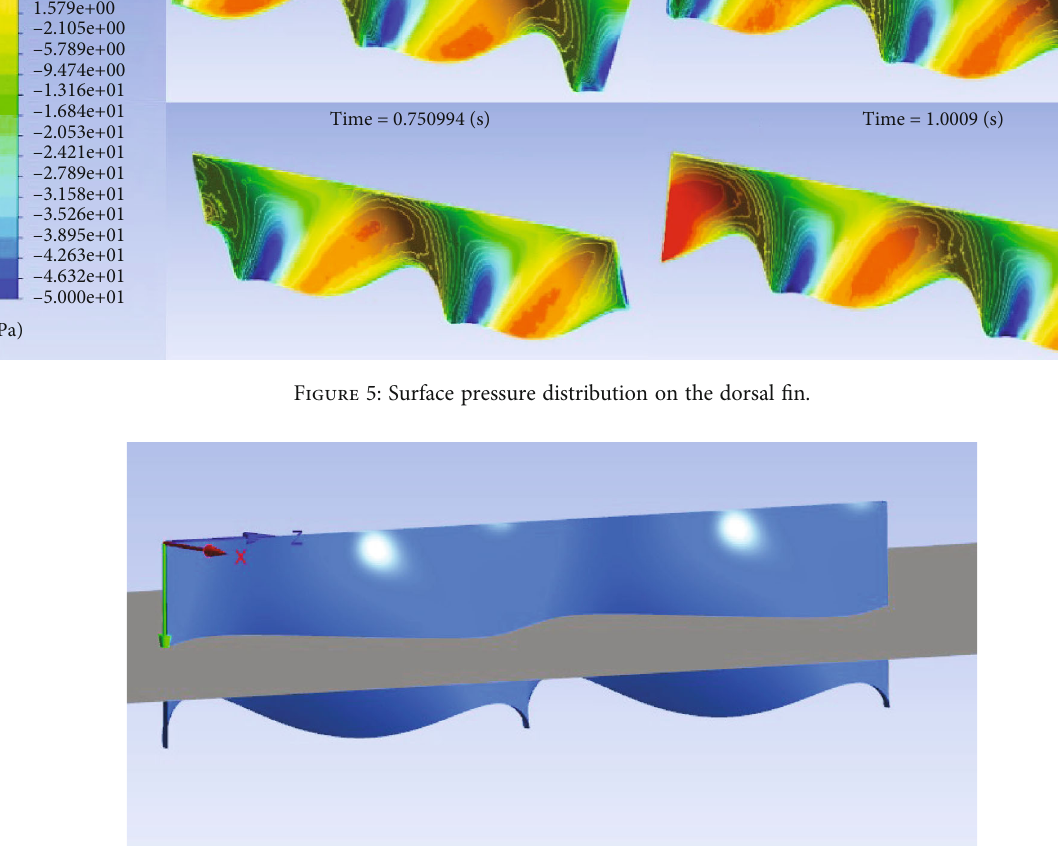
Figure 6: Section position.